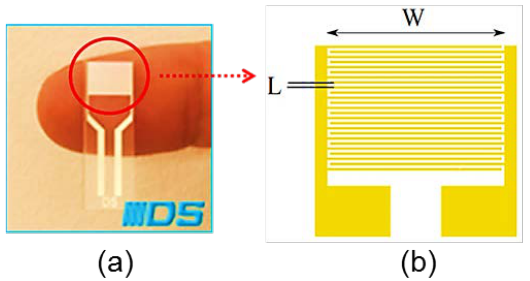
Figure 1. ( a ) Interdigitated electrodes (IDE) and ( b ) sketch diagram of the IDE.